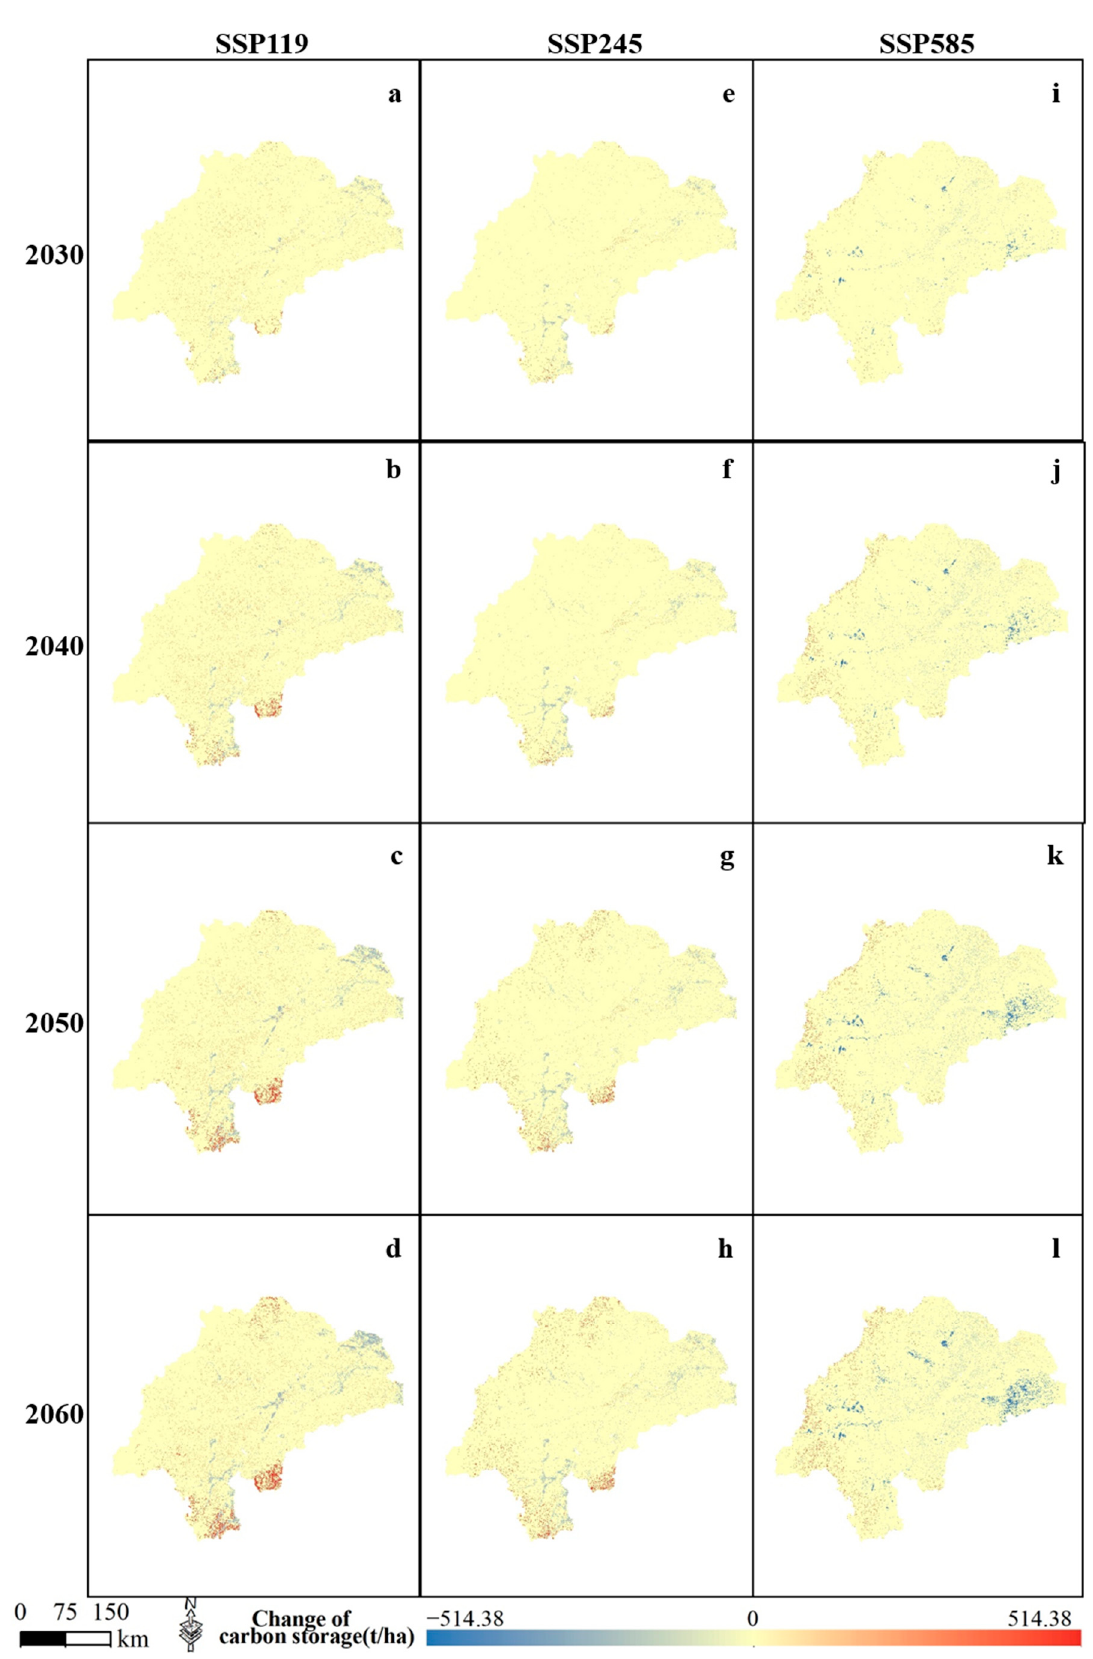
Figure 7. Changes in the spatial distribution of the carbon storage compared to 2020 under SSP119 ( a – d ), SSP245 ( e – h ), and SSP585 ( i – l ) for four future periods: 2030s, 2040s, 2050s, and 2060s.